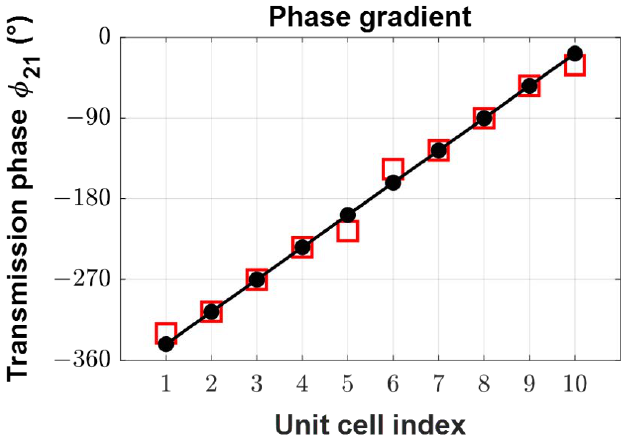
Figure 9. A comparison of the transmission phases used for the original and perturbed phase gradi- ents. The solid black circles indicate the transmission phases used for the linear phase gradient. The empty red squares indicate the transmission phases that are used for the perturbed phase